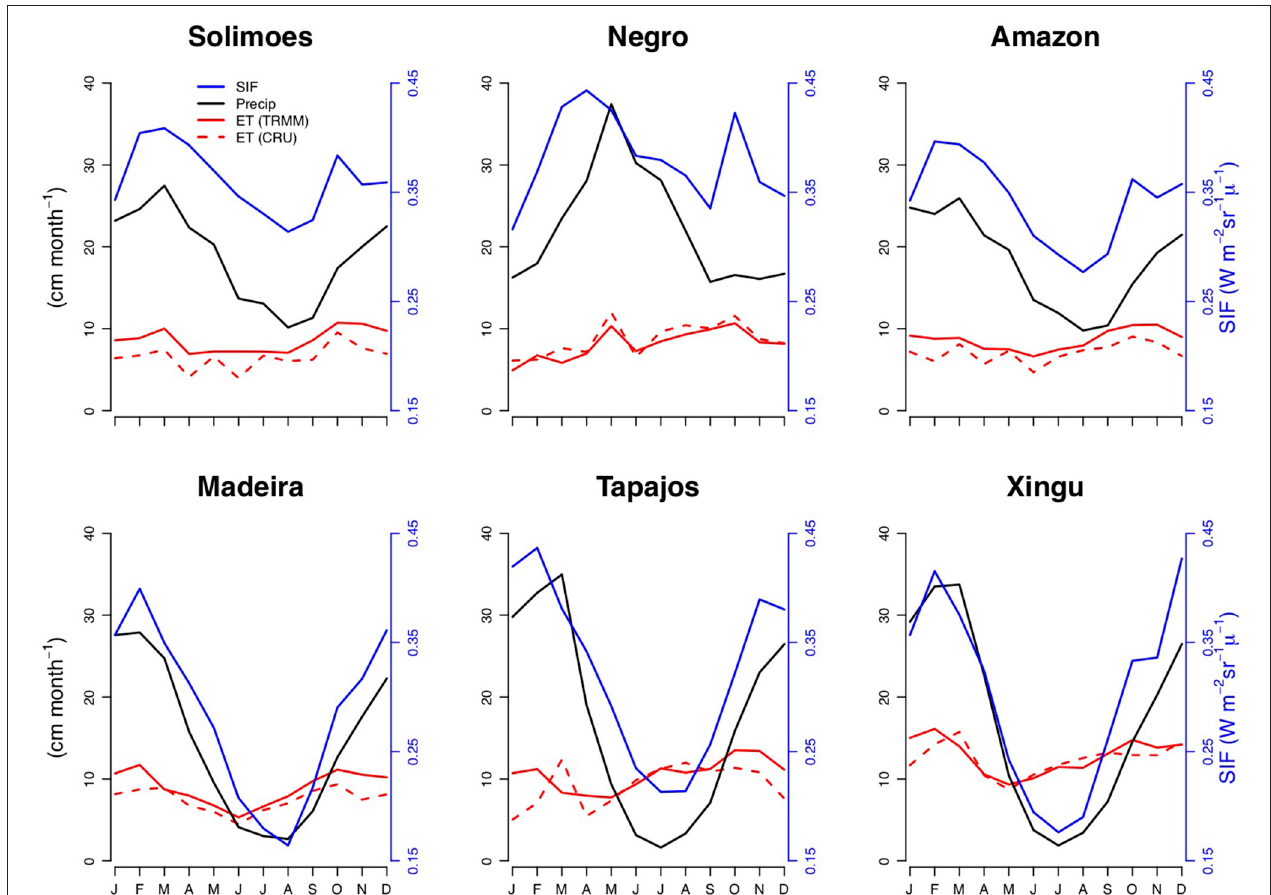
FIGURE 3 | Seasonal variations of evapotranspiration, solar induced fluorescence (SIF) and precipitation for the catchments in Figure 1